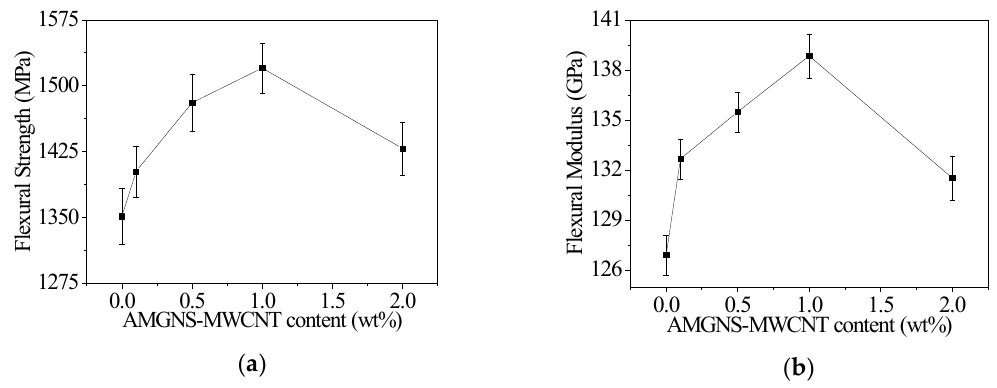
Figure 5. Flexural properties of the AMGNS-MWCNT/CFEP unidirectional composites: ( a ) flexural strength; ( b ) flexural modulus.